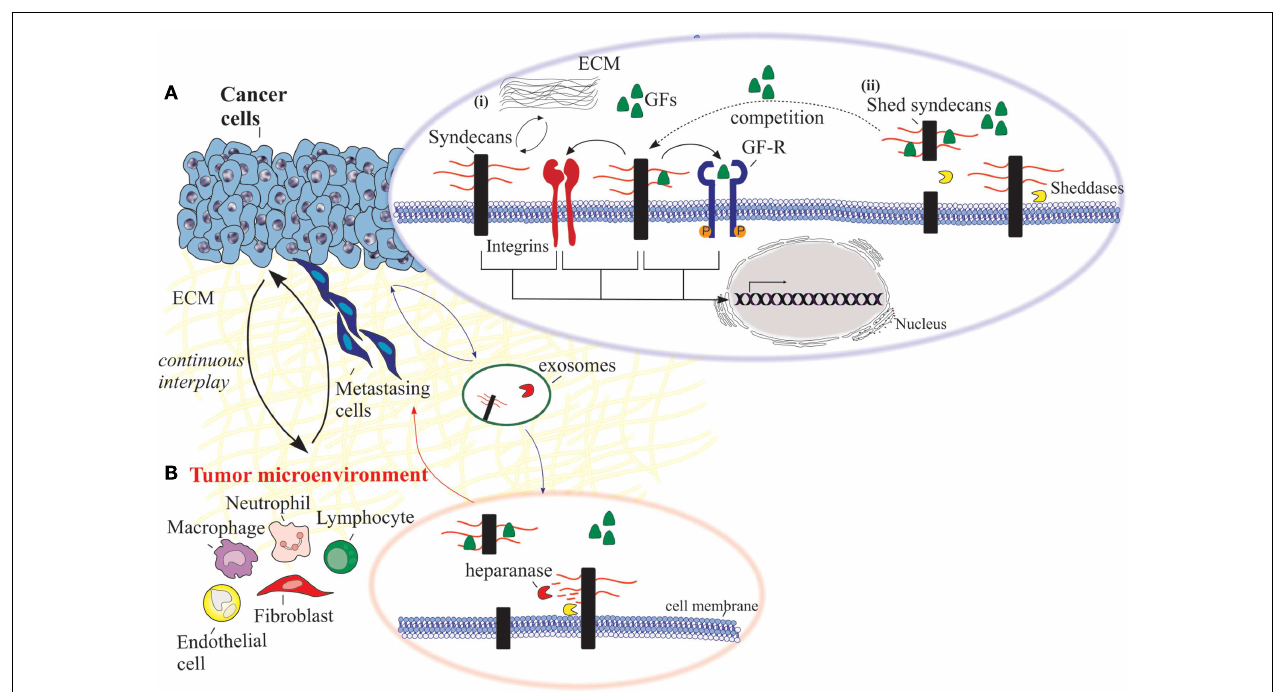
sheddases. It is also reported that the shed syndecans compete with their transmembrane counterparts for soluble GFs. Shedding of syndecans contributes to cancer progression and especially to the crosstalk between the tumor cells and their host microenvironment. Exosomes, extracellular vesicles that are secreted in high amounts in tumors, retain both heparanase and syndecan-1 as cargo within exosomes and subsequently influence not only the behavior of the tumor microenvironment within the tumor niche and distant sites, but also the growth of the metastasizing cells. (B) Tumor microenvironment. Heparanase plays a distinct role in the shedding of syndecans by cleaving HS chains promoting the shedding via sheddases.This action results in induced tumor growth, angiogenesis and